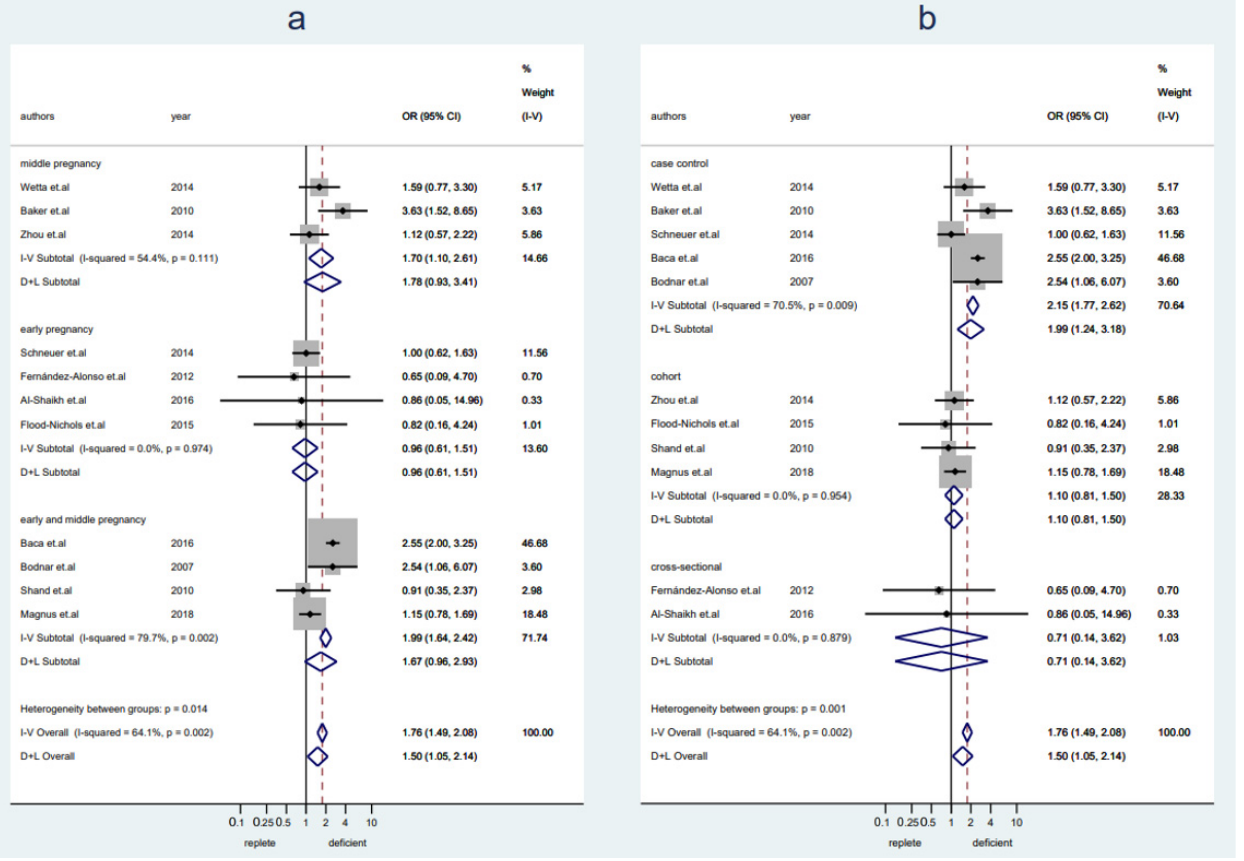
Figure 4. Studies evaluating replete vitamin D levels versus deficient vitamin D levels. ( a ): Studies were stratified by gestational weeks (early, middle, and early and middle not specified); ( b ): studies were stratified by the study design.